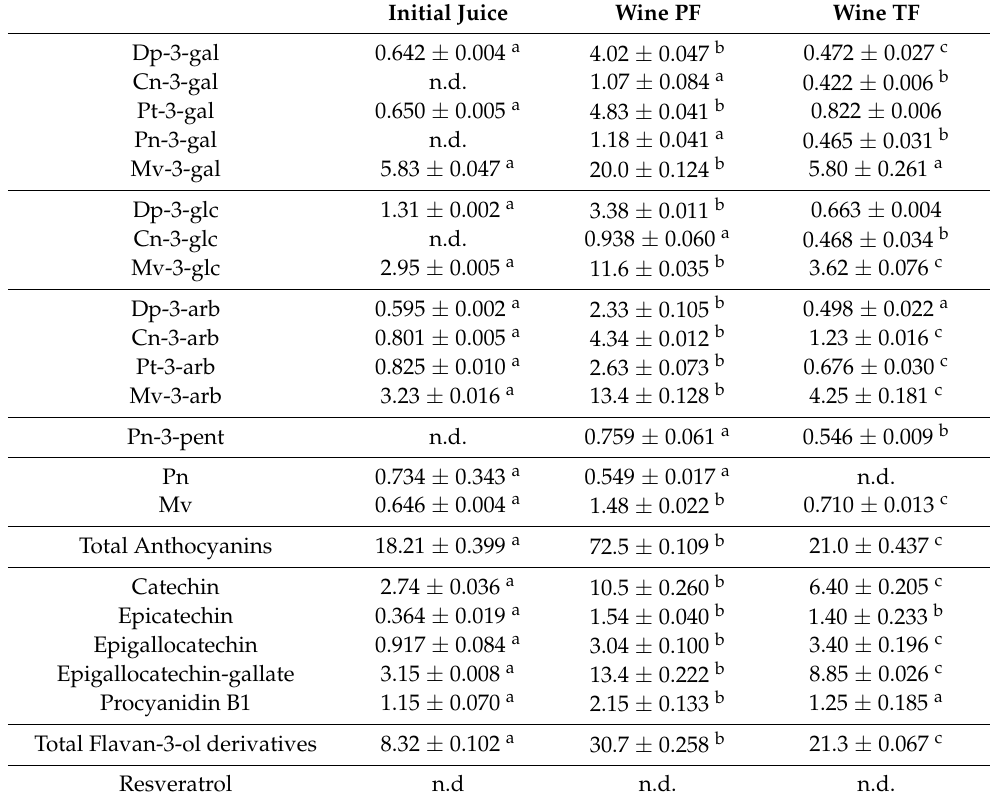
Table 2. Flavonoid contents (mg/L) and resveratrol in initial juice and wines from Windsor blueberry (means, standard deviations and homogenous